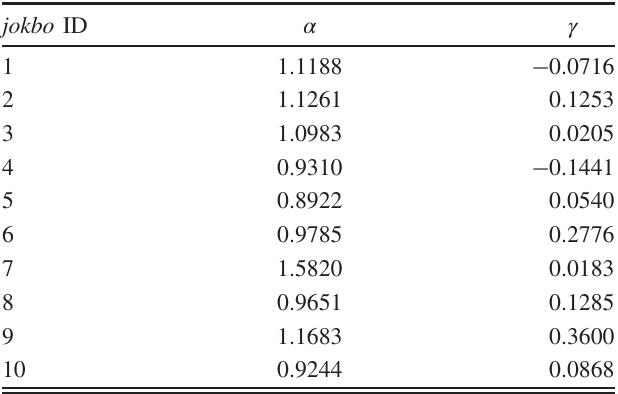
TABLE III. Gravity-model parameters α and γ in Eq. (1) calculated using the clan origin locations (instead of the population centroids from the census data) for all of the jokbo by minimizing the sum of squared differences using the SCIPY . OPTIMIZE package in P YTHON [35]. (We again use initial 1 . 0 for jokbo 1 – 2, 4 – 6, and 8 – 10. For values of α ¼ γ ¼ a G ¼ 1 . 0 and γ ¼ 0 . 01 jokbo 3 and 7, we instead use α ¼ a G ¼ because the procedure did not converge when we used